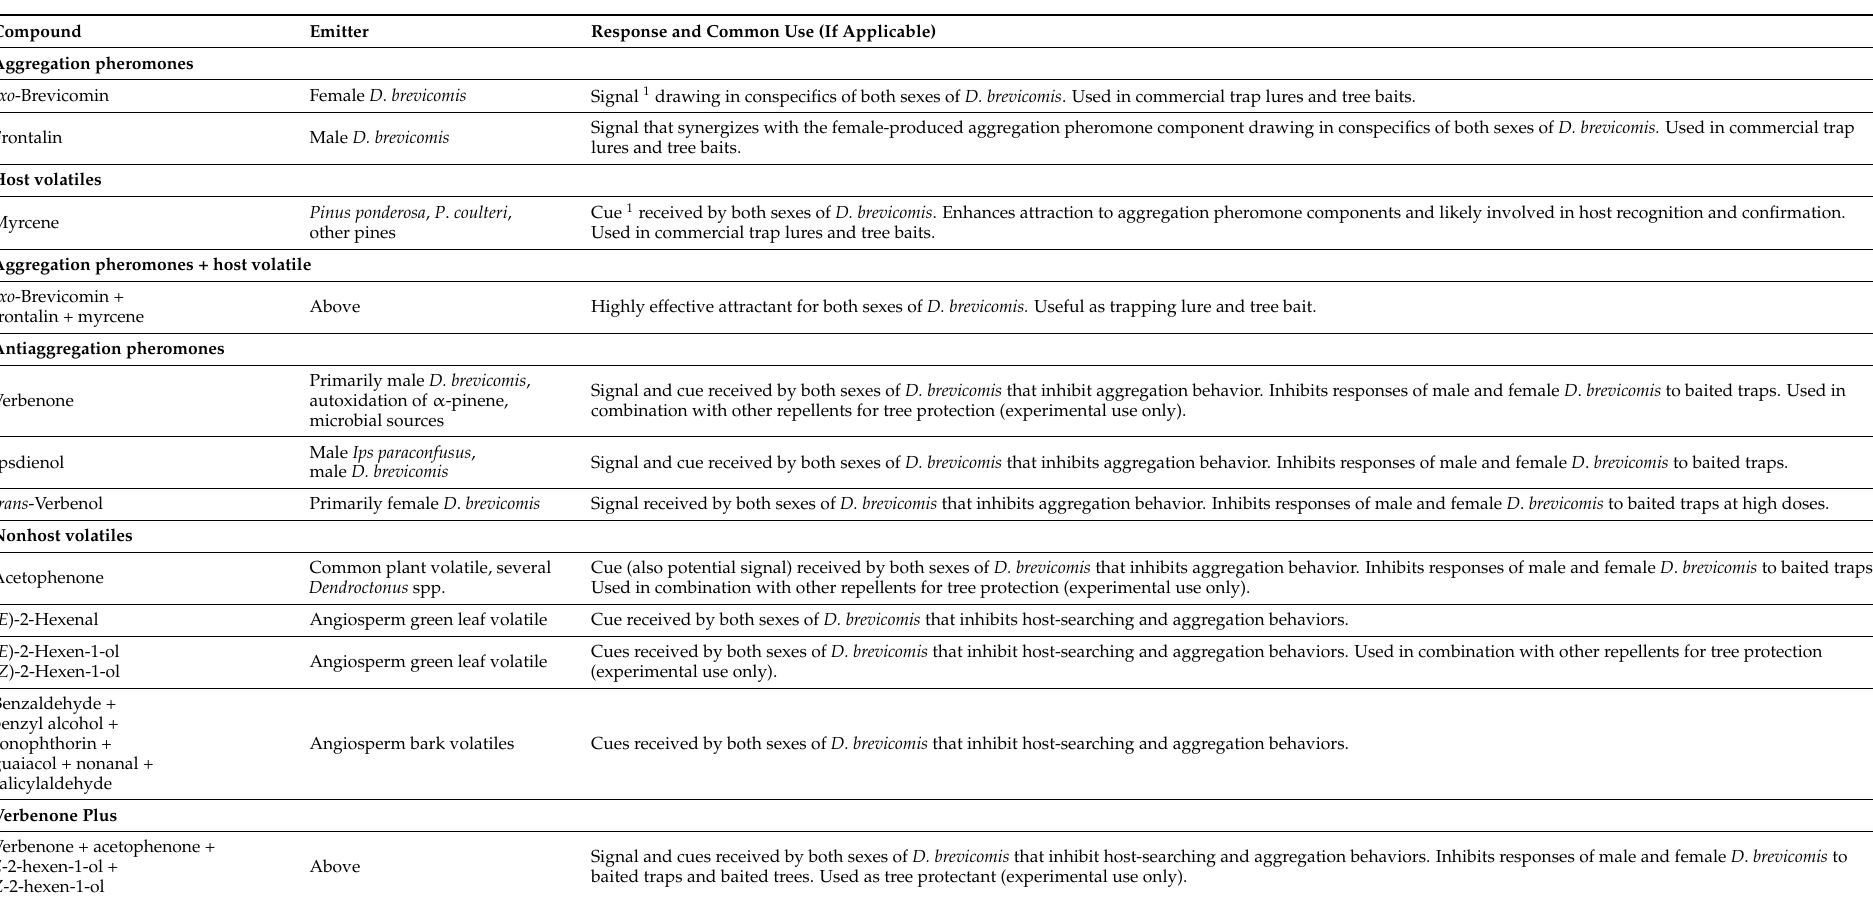
Table 1. Major semiochemicals associated with western pine beetle ( Dendroctonus brevicomis ) used in management and/or